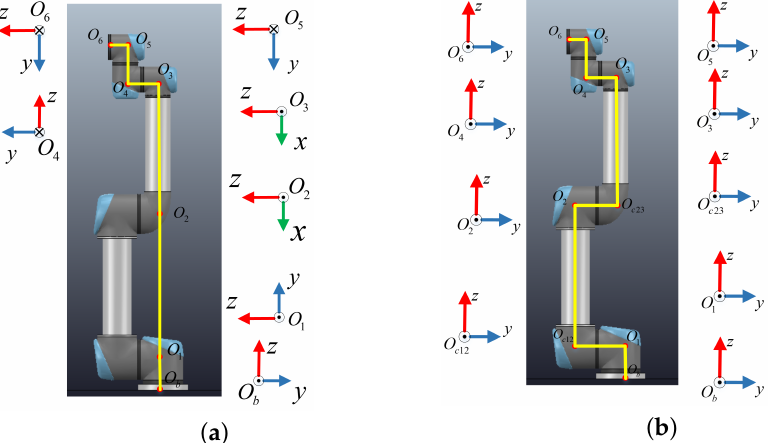
Figure 2. Some coordinate frames established for the kinematic modeling of the manipulator subsys- tem. ( a ) Kinematic modeling based on the classical method; ( b ) Kinematic modeling based on the optimized